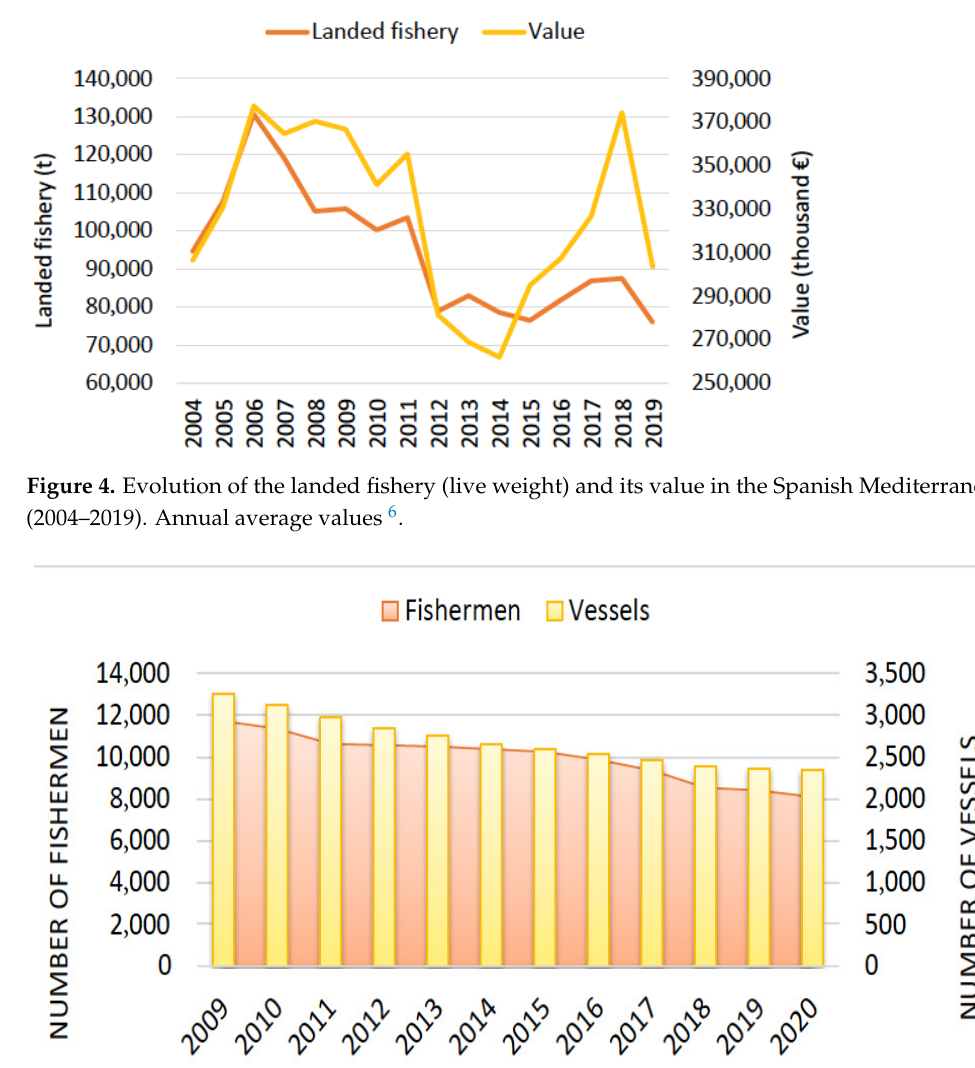
Figure 5. Comparison of the evolution of the total number of vessels and the average number of fishermen affiliated to REM in the Mediterranean 7 .